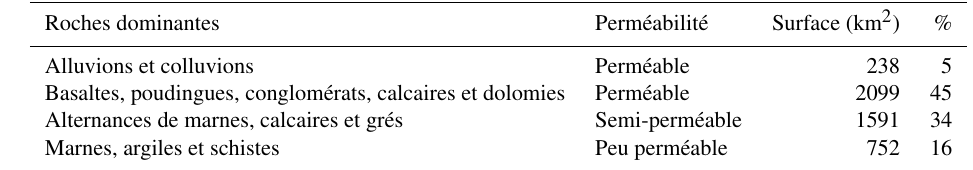
Tableau 1. Synthèse lithologie/perméabilité dans le bassin versant du Haut Sebou. Roches dominantes Perméabilité Surface (km 2 ) % Alluvions et colluvions Perméable Basaltes, poudingues, conglomérats, calcaires et dolomies Perméable Alternances de marnes, calcaires et grés Semi-perméable Marnes, argiles et schistes Peu